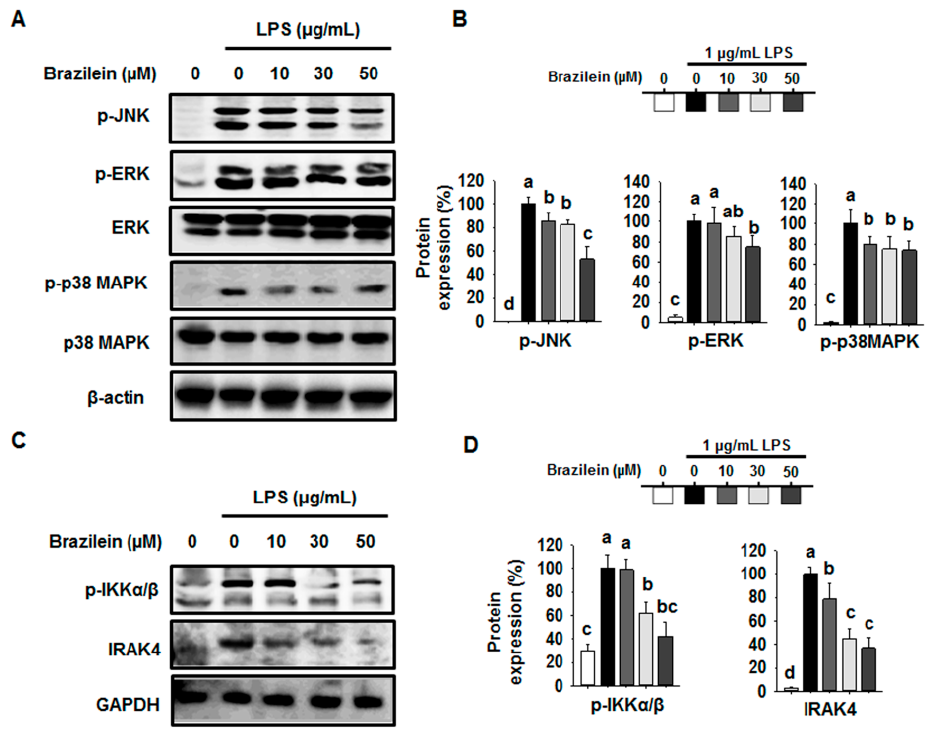
Figure 5. Effect of brazilein on the expression of p-IKK β , IRAK4, and MAPK signaling pathway in LPS stimulated Raw264.7. Cells were pretreated with 10, 30 or 50 μ M brazilein for 1 h and then stimulated with 1 μ g/mL LPS for 30 min or 24 h. DMSO was used as a vehicle. Equal amounts of protein in cell lysates were analyzed by Western blot. GAPDH protein levels were used to confirm that equal amounts of protein were subjected to electrophoresis. ( A ) The expression levels of c-Jun terminal kinase (JNK), extracellular signal-regulated protein kinase (ERK)1/2, and p38MAPK protein; ( B ) The quantification histogram of p-JNK, p-ERK1/2, and p-p38MAPK protein expression normalized by β -actin; ( C ) Expression of p-IKK β and IRAK4 protein; ( D ) The quantification histogram of p-IKK α / β and IRAK4 protein expression normalized by β -actin. The data are expressed as mean ± standard deviations (SD), ( n = 3). Values with different letters are significantly different, p < 0.05.